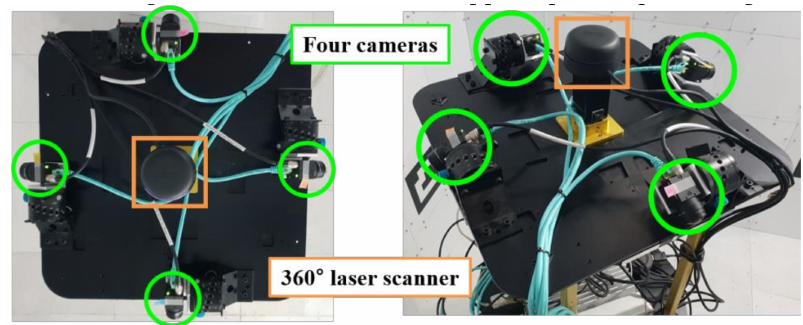
Figure 13. Configuration of four cameras and a 360 ◦ laser scanner on the